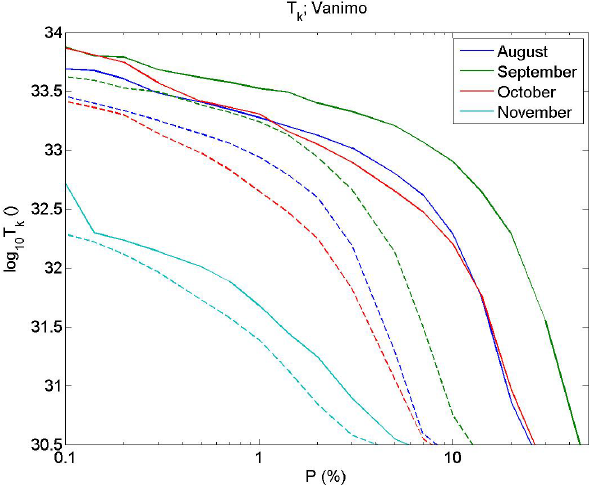
Fig. 4. CDF of log 10 T k over Vanimo in four monhs of autumn 2001; full time (dashed lines) and between 18:00 and 24:00 only (solid